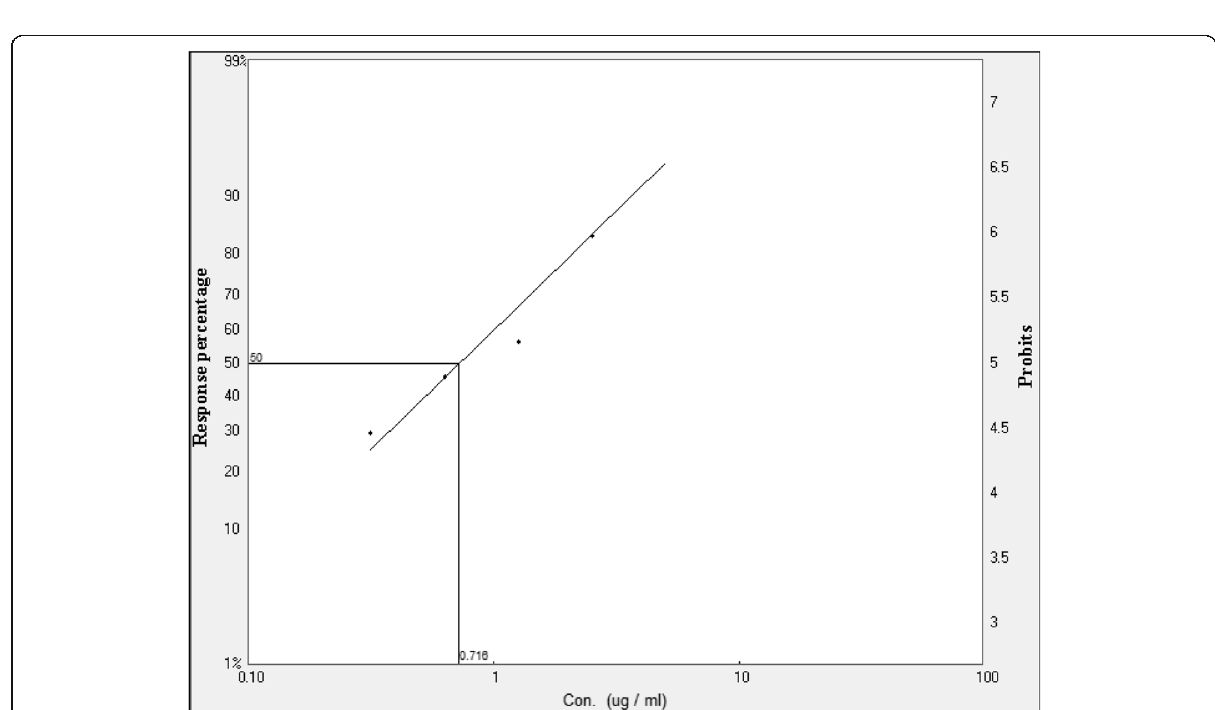
Fig. 6 LC 50 of the standard vincristine